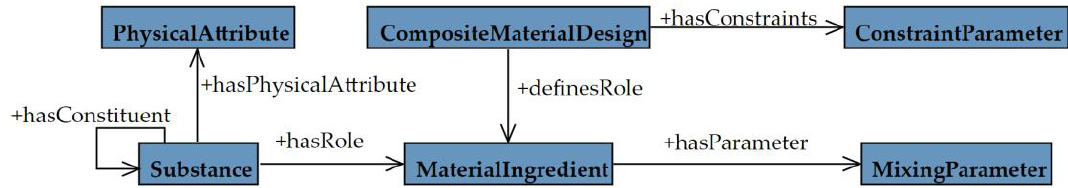
Figure 10. DUL Alignment of Material Mix Design.